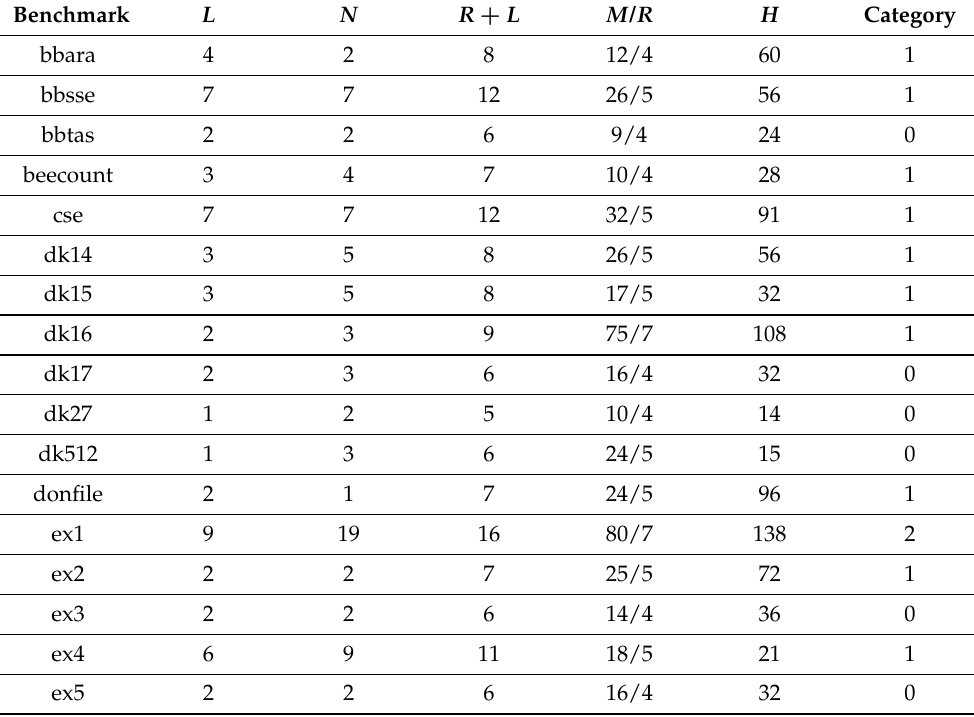
Table 7. Characteristics of benchmark Mealy FSMs